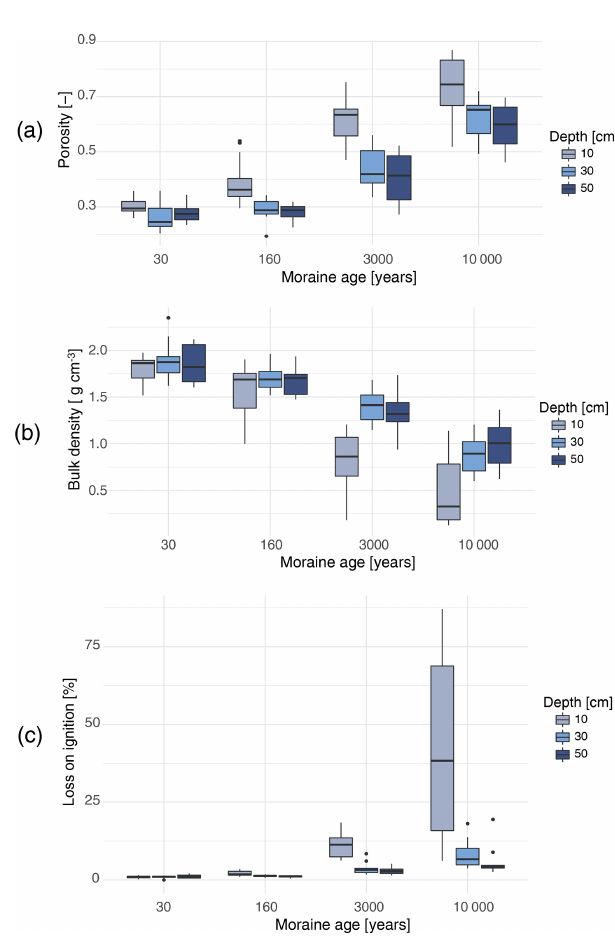
Figure 6. Evolution of soil porosity (a) , bulk density (b) , and loss on ignition (c) in 10, 30, and 50cm